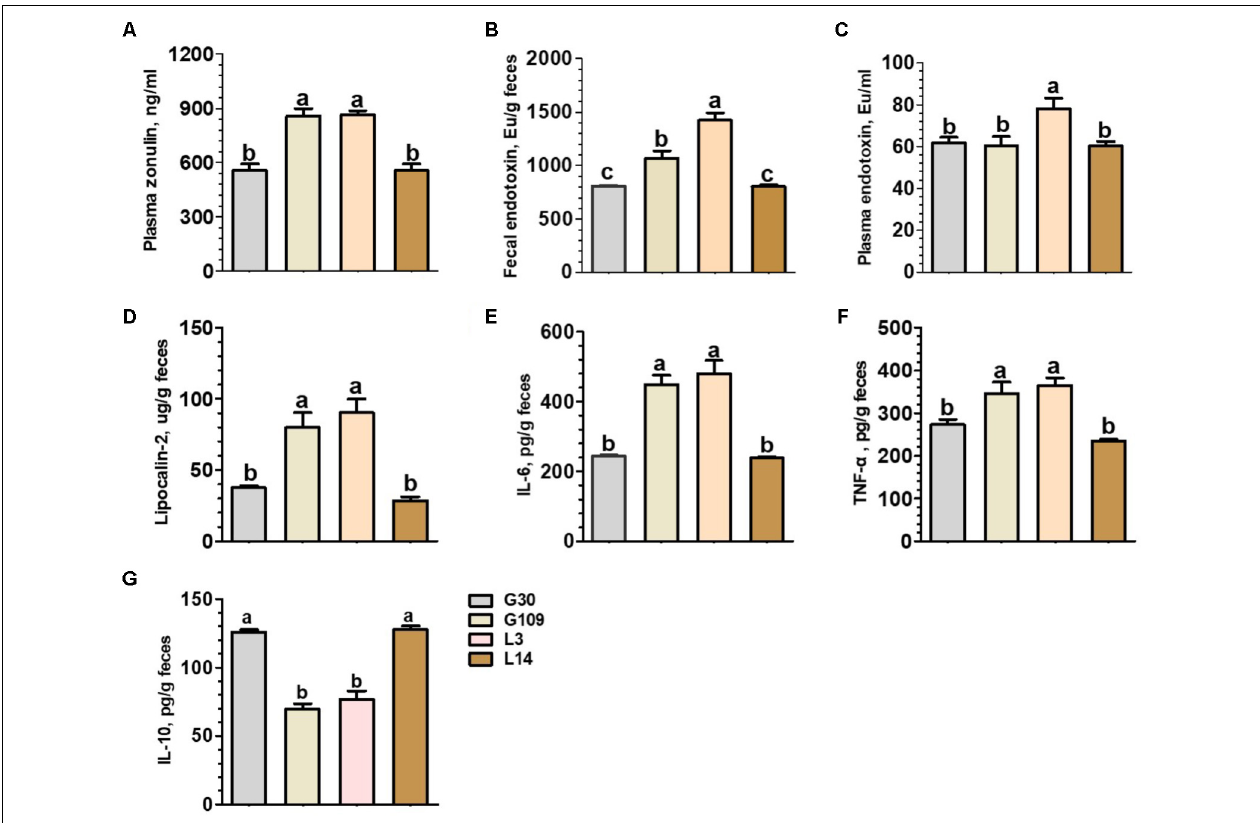
FIGURE 7 | Plasma concentrations of zonulin (A) and endotoxin (C) and fecal concentrations of endotoxin (B) , Lipocalin-2 (D) , IL-6 (E) , TNF- α (F) , and IL-10 (G) of the sows during gestation and lactation. Data are presented as means ± SEM ( n = 12). a–c, significant effect of sampling day (values with different lowercase letters are significantly different). G109, day 109 of gestation; L3, day 3 of